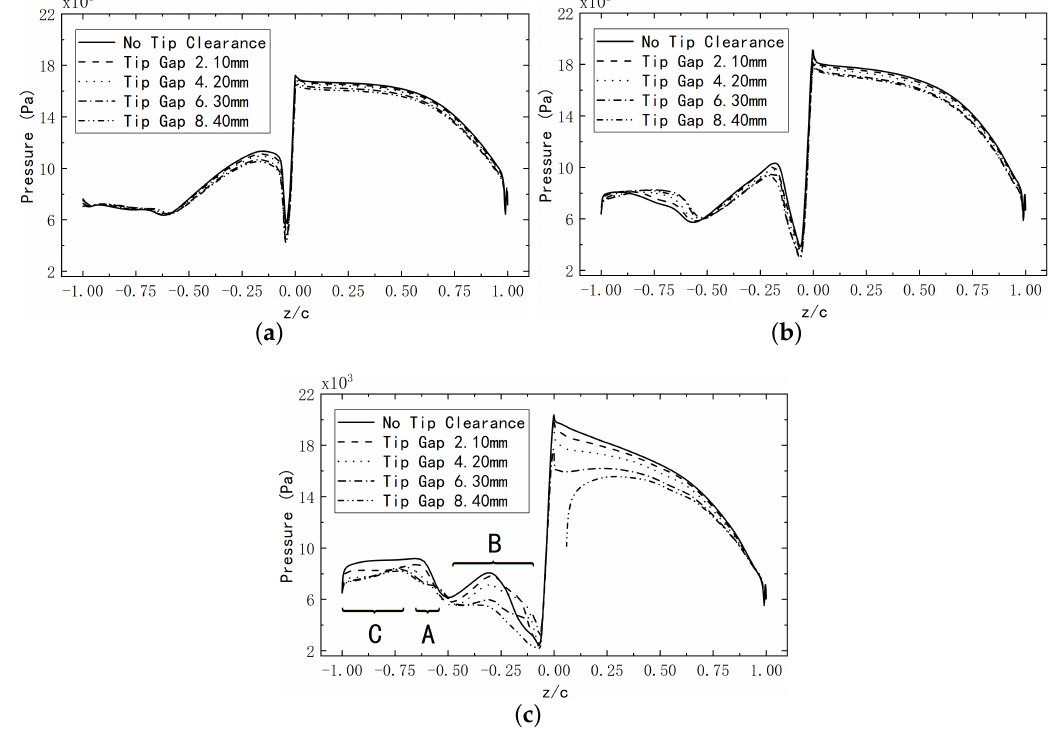
Figure 5. Blade loading in steady state at ( a ) 80%, ( b ) 90%, and ( c ) 98% span for the five studied models; the abscissa is the ratio of chord coordinates to the length of the chord, in which − 1–0 indicate the trailing edge to the the leading edge on the suction surface and 0–1 indicate the leading edge to the trailing edge on the pressure